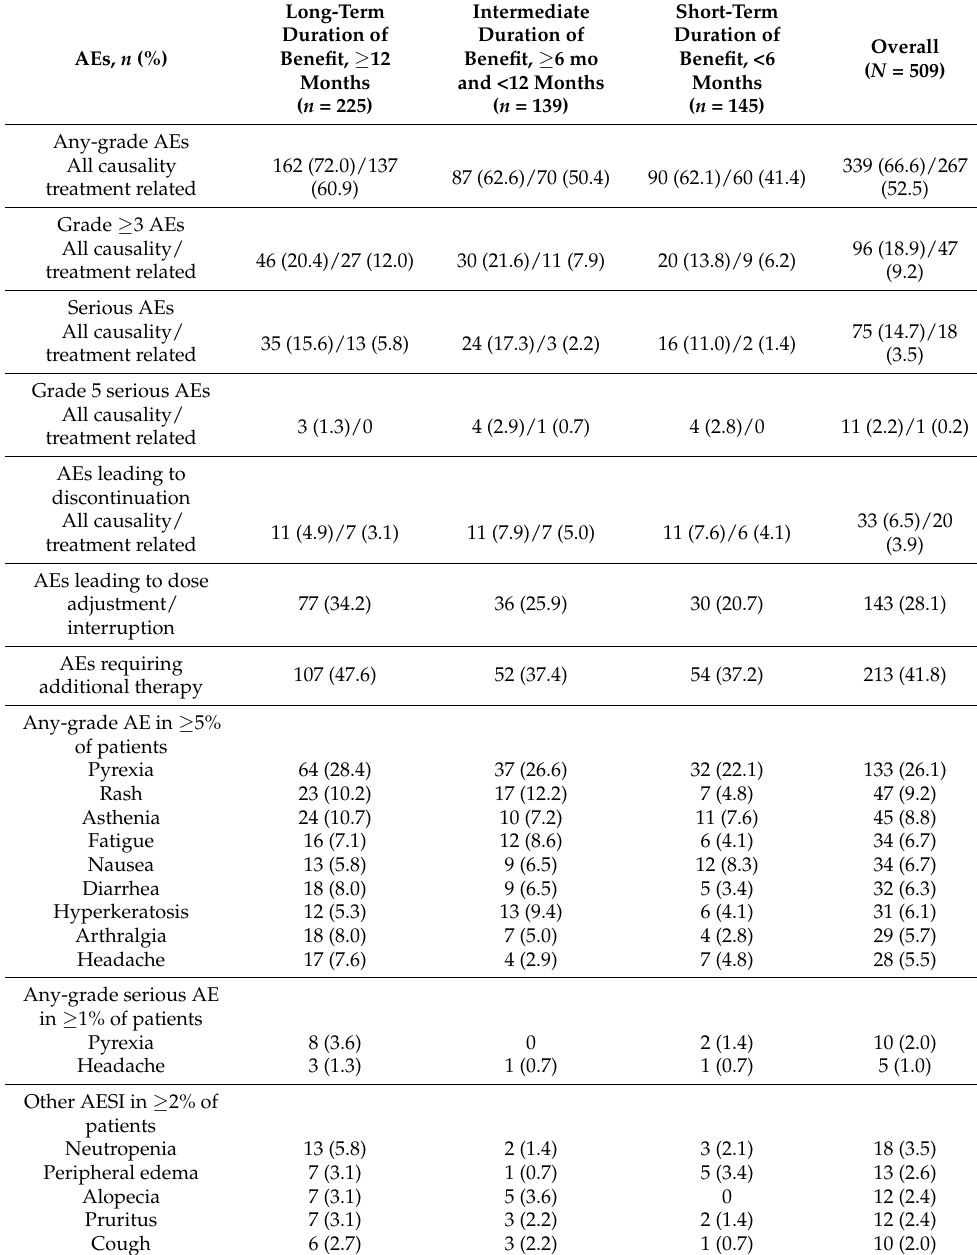
Table 3. Summary of safety outcomes by